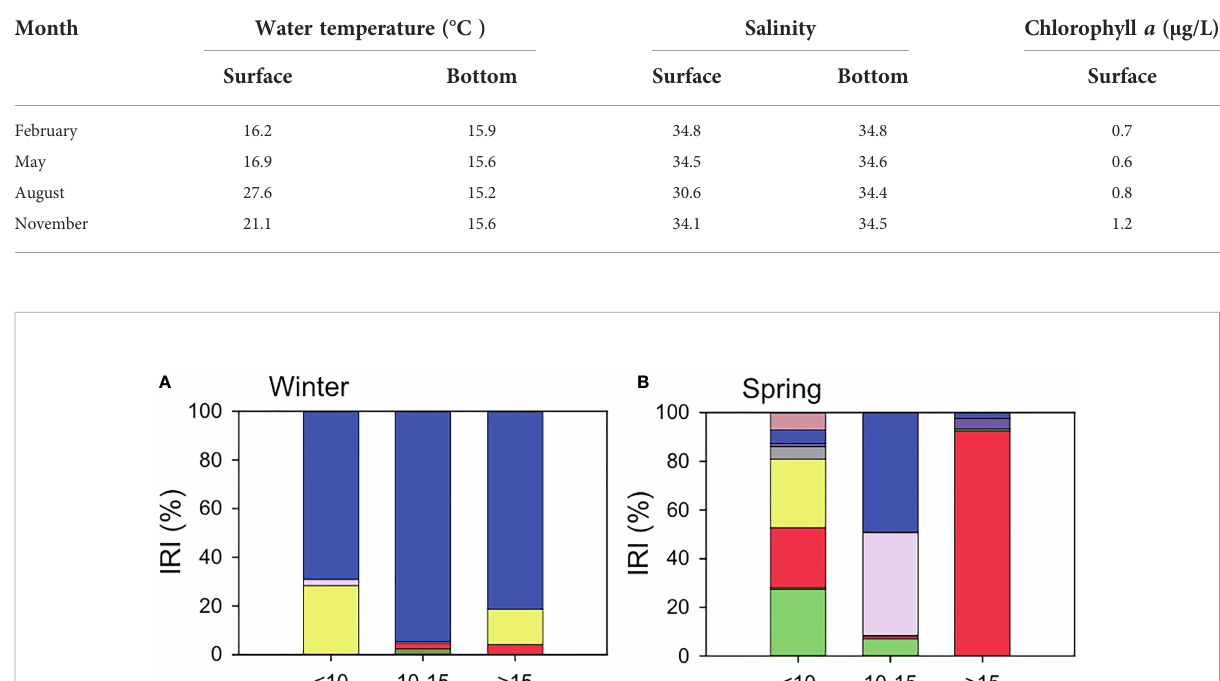
TABLE 1 The environmental conditions (water temperature, salinity, and chlorophyll a ) at the surface and bottom layers in the South Sea of Korea during February, May, August, and November